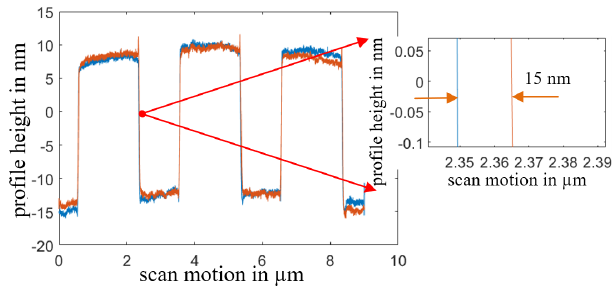
Figure 9. Step height measured forwards and